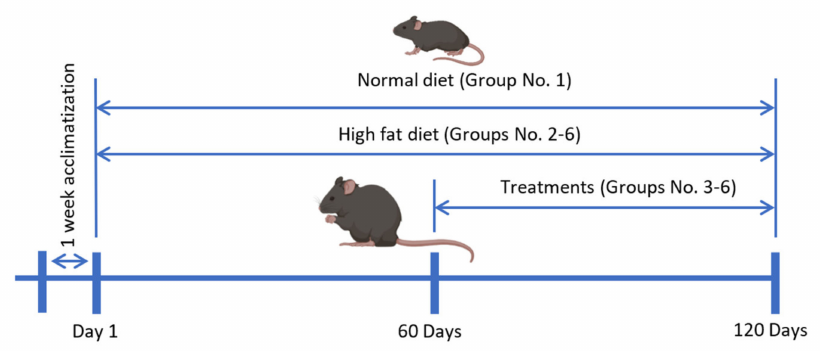
Figure 13. The timeline of the animal